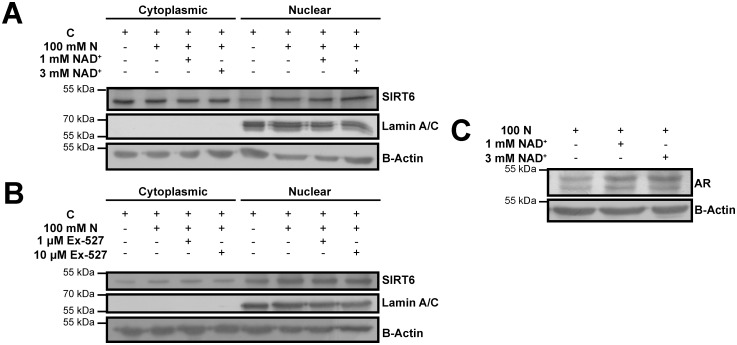
The cofactor of SIRT6, NAD+ positively regulated nuclear SIRT6 accumulation and total AR expression under hyperosmotic stress.Control (C) indicates U937 cells treated with 5 mM glucose containing SFM for 16 hrs in (A) and (B). 100 mM N indicates U937 cells further treated with 100 mM NaCl (N) for 16 hrs in (A), (B) and (C). U937 cells were pretreated either with solvent (DMSO) or indicated concentrations of NAD+ or Ex-527 for 1 hr, followed by 16 hrs of 100 mM N treatment in (A), (B) and (C). (A)(C) The cofactor of SIRT6, NAD+, enhanced the nuclear accumulation of SIRT6 and total AR expression in dose-dependent manner under hyperosmotic stress. (B) A specific SIRT1 inhibitor and recently suggested SIRT6 inhibitor, Ex-527 did not altered nuclear SIRT6 expression under hyperosmotic stress, in part, justifying the data obtained in (A). Expressions were evaluated using immunoblotting in cytoplasmic and nuclear extracts in (A) & (B) and in total extracts in (C). Results obtained from this figure was based on the densitometry based statistical analyses, given in S4 Fig.